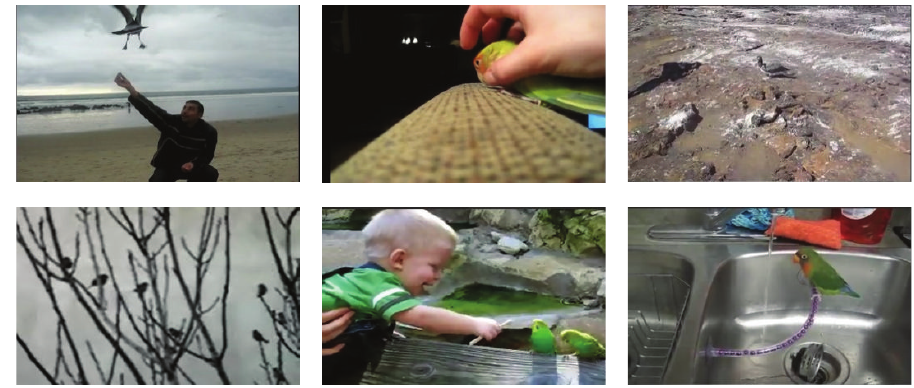
Figure 1: Example video frames of event “bird” defined in Columbia Consumer Video